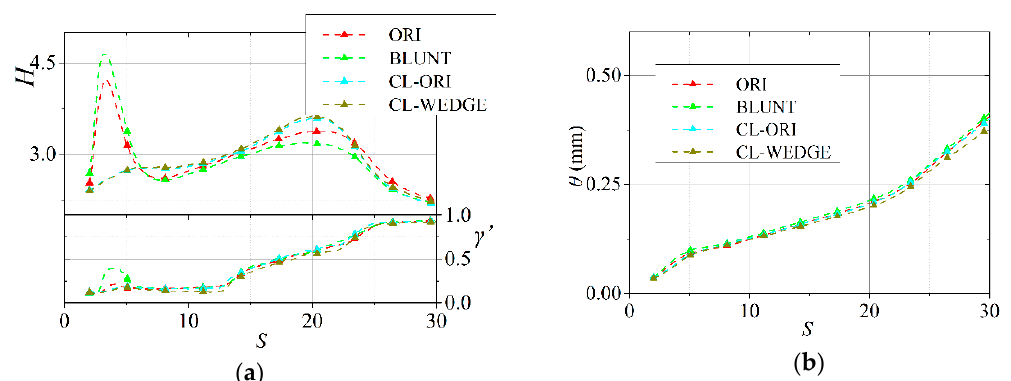
Figure 21. The different leading edge boundary layer developments in the 0.5 blade height at Tu = 2.5%, Re t = 2500: ( a ) the boundary layer shape factor and normal average turbulence intermittency; ( b ) the momentum thickness along aerofoils.